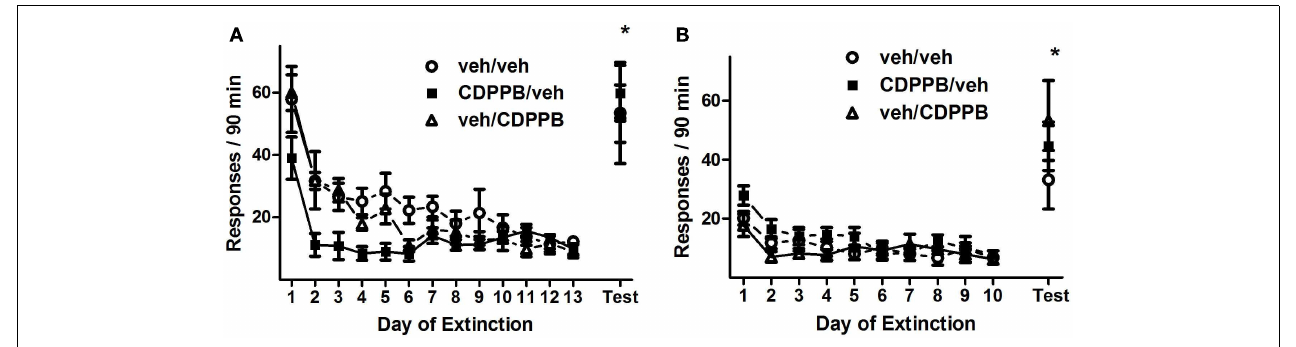
during the second extinction phase, followed by the final cue reinstatement test session. Filled symbols indicate pretreatment with 30mg/kg CDPPB on Days 1–7, and open symbols indicate corresponding vehicle treatment. * p < 0.05 difference between reinstatement testing and average of final two extinction sessions, in all treatment groups (paired t